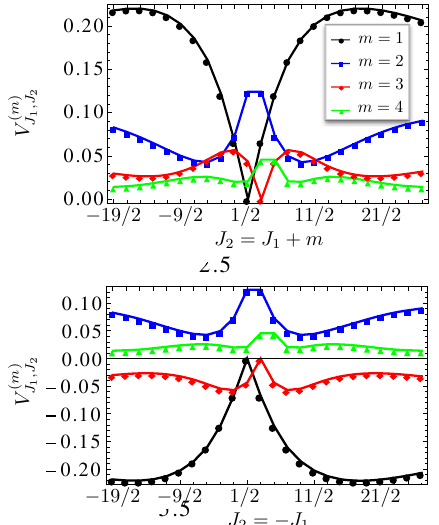
FIG. 2. Coulomb-matrix elements, in units of λ ℏ ω , vs angular momentum J 2 . The plots are for α ¼ 10 and various m . The upper (lower) panel shows the case J 2 ¼ J 1 þ m ( J 2 ¼ − J 1 ), respec- tively; see the solid lines in Fig.